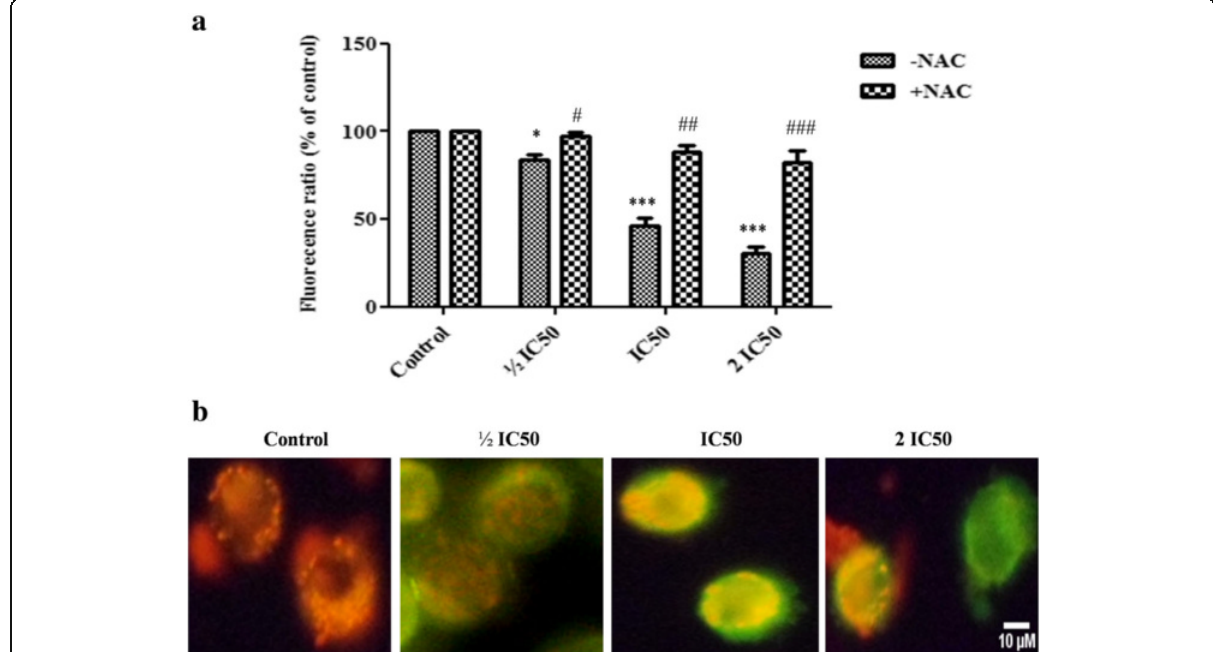
Fig. 8 Changes of mitochondrial membrane potential ( Δ Ψ m ) induced by F3 fraction in NCI-H358 cells. a Concentration-dependent reduction of red/green fluorescence ratio corresponding to loss of Δ Ψ m in NCI-H358 cells elicited by increasing concentration of F3 fraction (½ IC 50 , IC 50 and 2 IC 50 ) for 4 h. The results are expressed as the mean±SD of triplicate determinations, representative of three independent experiments. Significances indicated were in comparison to control cells and to the preincubated cells with NAC for each F3 fraction dose (* p <0.05; *** p <0.001 vs. control cells and # p <0.05; ## p <0.01; ### p <0.001, vs. the corresponding dose of F3 fraction with NAC pre-treatment). b Microscopic images of Δ Ψ m dissipation in NCI-H358 cells after 4 h of treatment with F3 fraction (½ IC 50 , IC 50 and 2 IC 50